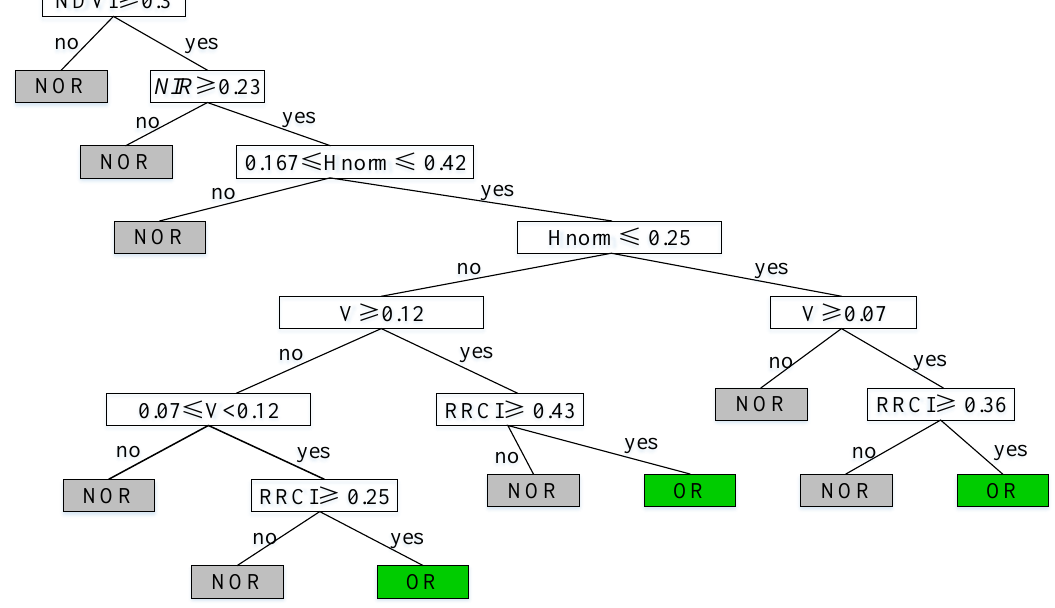
Figure 9. The decision tree for extracting oilseed rape based on the CSRA approach.